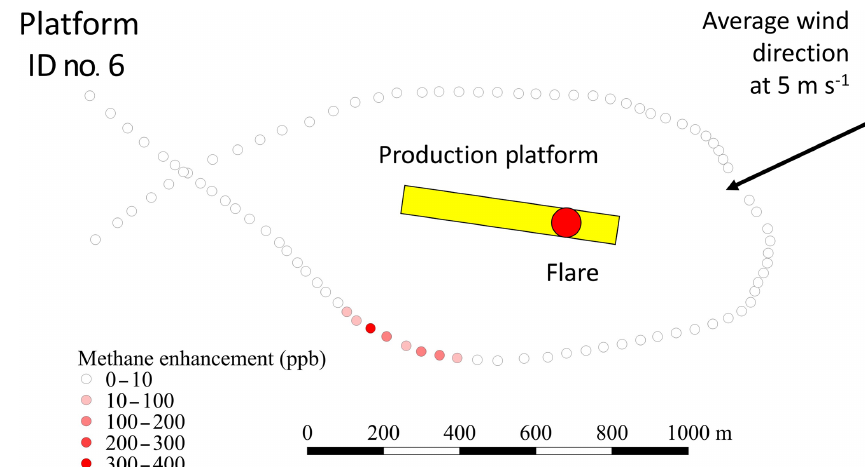
Figure 2. Minute-averaged CH 4 enhancements made upwind and downwind of production platform no. 6, on 24 August